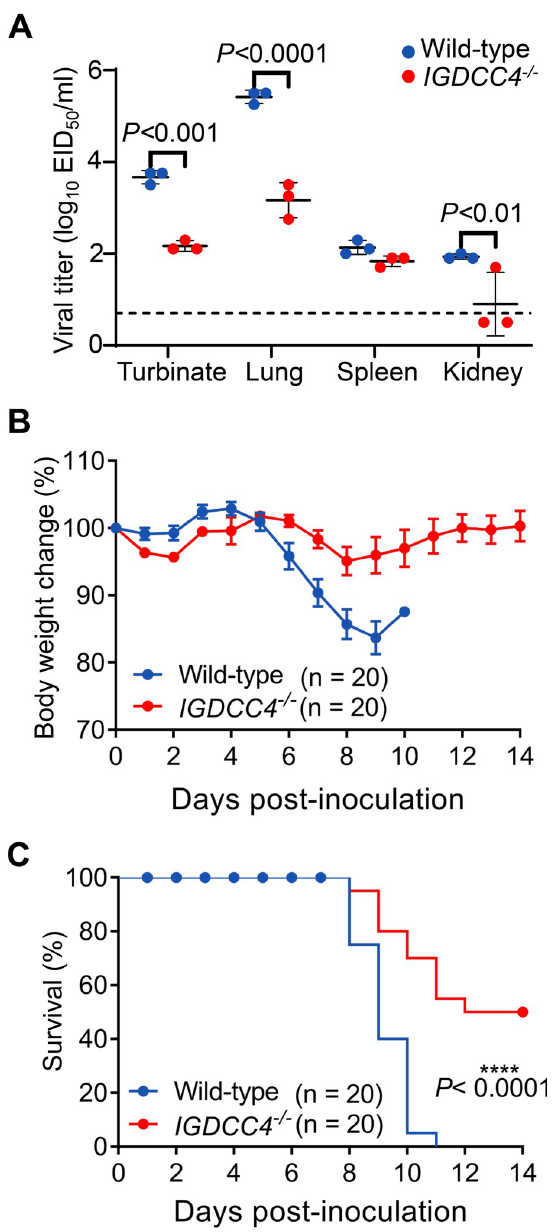
Fig 8. Replication and lethality of H5N1 virus in wild-type mice and IGDCC4 knockout mice. ( A ) Viral titers in organs of different mice. Wild-type mice and IGDCC4 knockout mice were euthanized on Day 3 post-infection with 5 MLD 50 of H5N1 virus, and their organs were collected for virus titration in chicken embryos. The data are presented as means ± SDs for organ samples of three mice. ( B ) Body weight change of wild-type mice and IGDCC4 knockout mice after H5N1 virus infection. The values are means ± SDs from surviving mice at the indicated timepoints. ( C ) Lethality of H5N1 virus to wild-type mice and IGDCC4 knockout mice. The two-tailed unpaired t -test was used for the statistical